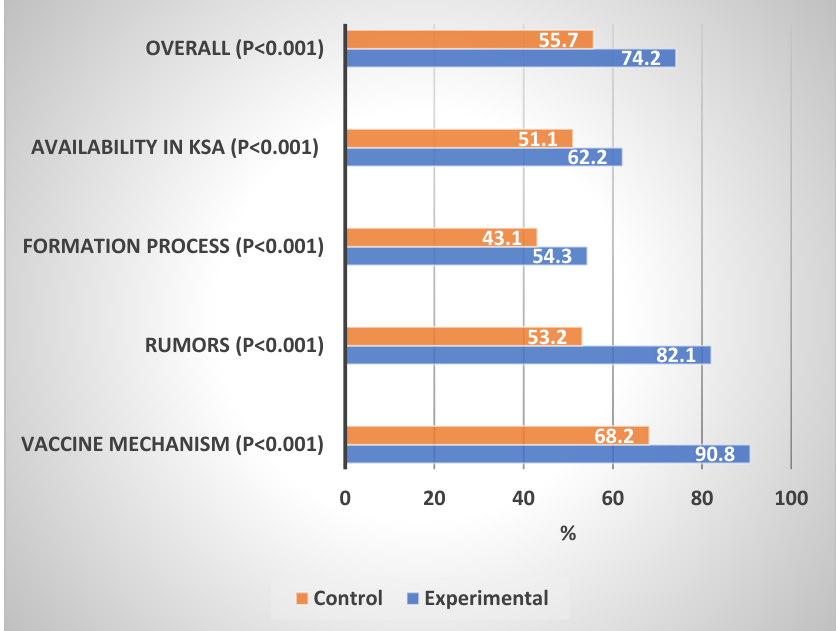
Figure 2. Percentage mean scores of the knowledge about COVID-19 vaccines. Differences in Experimental vs. Control Groups.